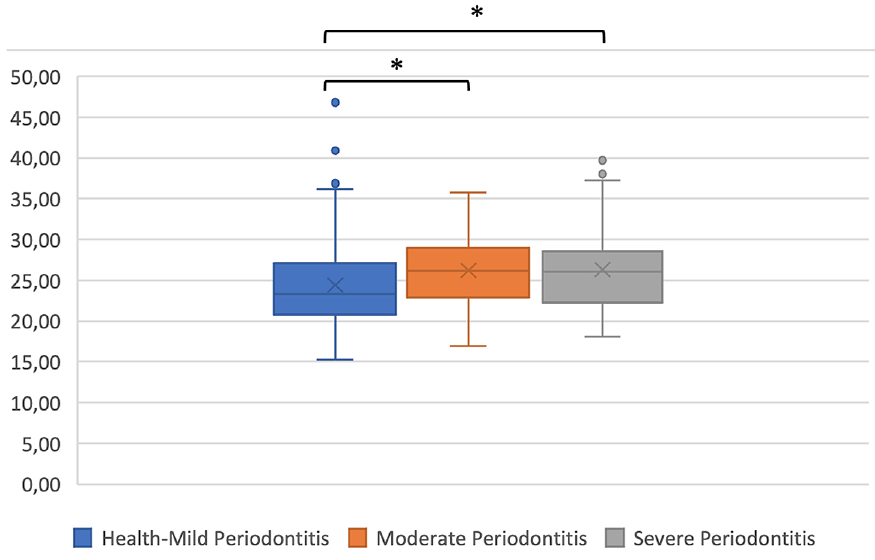
Figure 2. Body mass index and periodontal status; Kruskal-Wallis test *p <